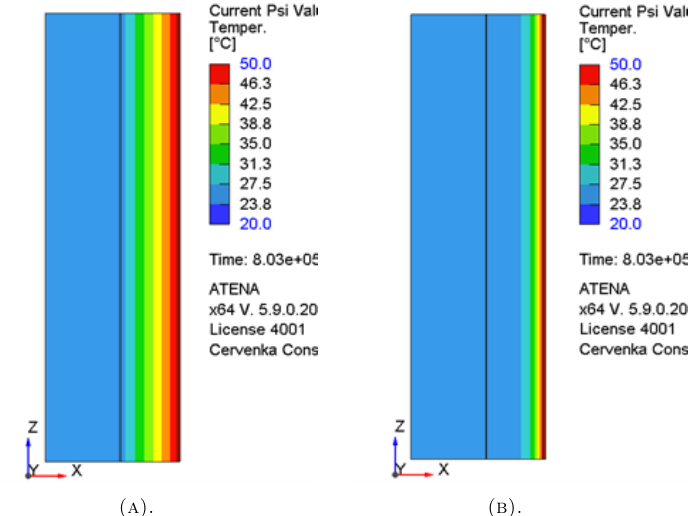
Figure 8. Comparison of temperature distribution at peak outer surface temperature for EPS (A) and PCM-336 (B) material for the warm condition case with cooling during day 9 of simulation (9.29 days = 80300 s).